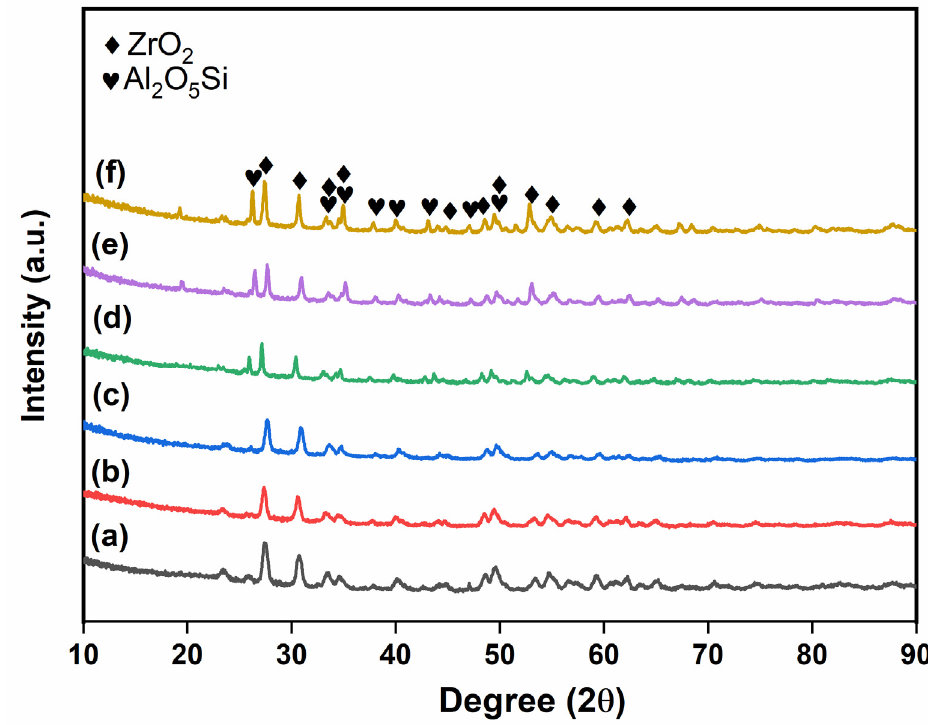
Figure 3. XRD patterns of the glass-ceramics with ZrO 2 additive: (a) 30Zr-O, (b) 40Zr-O, (c) 50Zr-O, (d) 30Zr-Ar, (e) 40Zr-Ar, and (f) 50Zr-Ar.